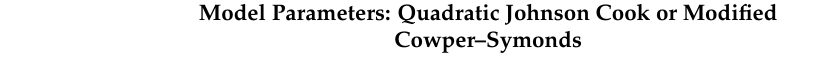
Table 7. Calibrated coefficients for the rate-dependent constitutive model in Equations (7) and (8).